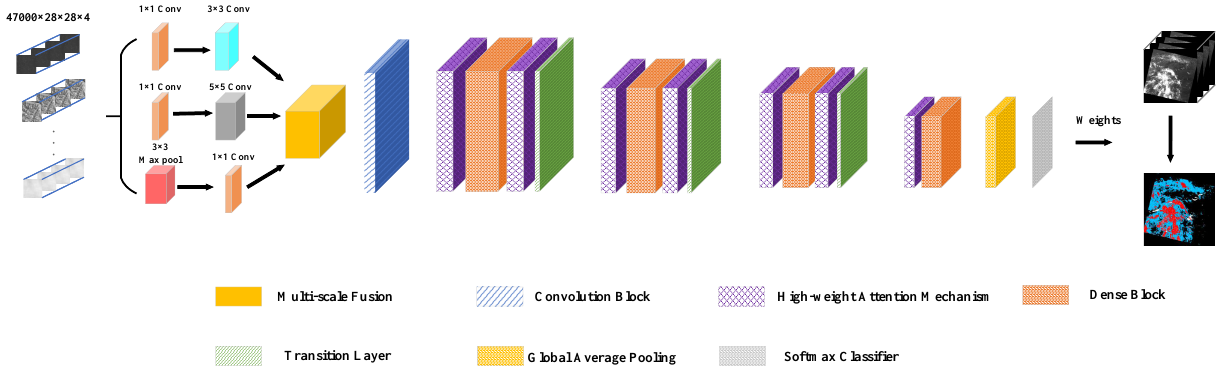
Figure 1. Multi-scale fusion attention